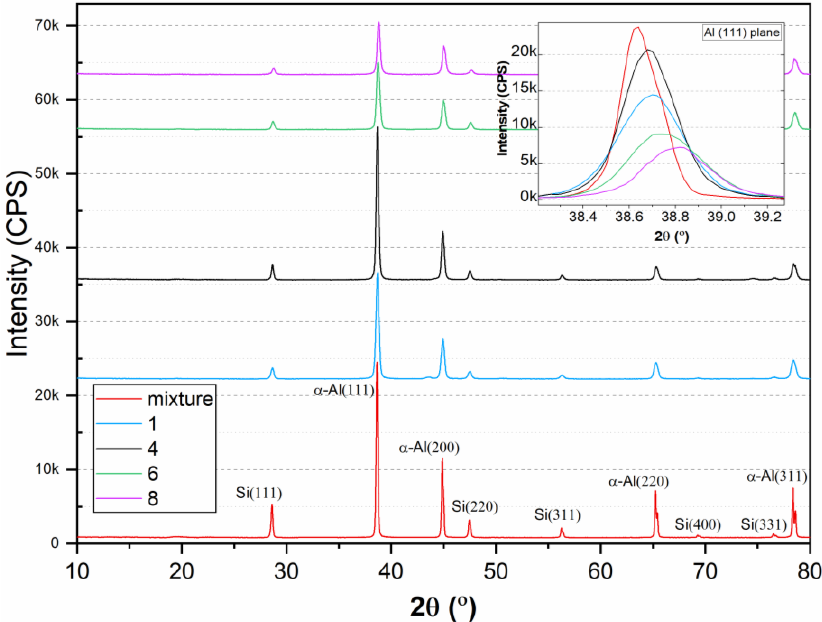
Figure 7. X-ray diffraction patterns of powder mixture and coatings, and the variation of Aluminum (111) lattice plane upon plastic deformation.